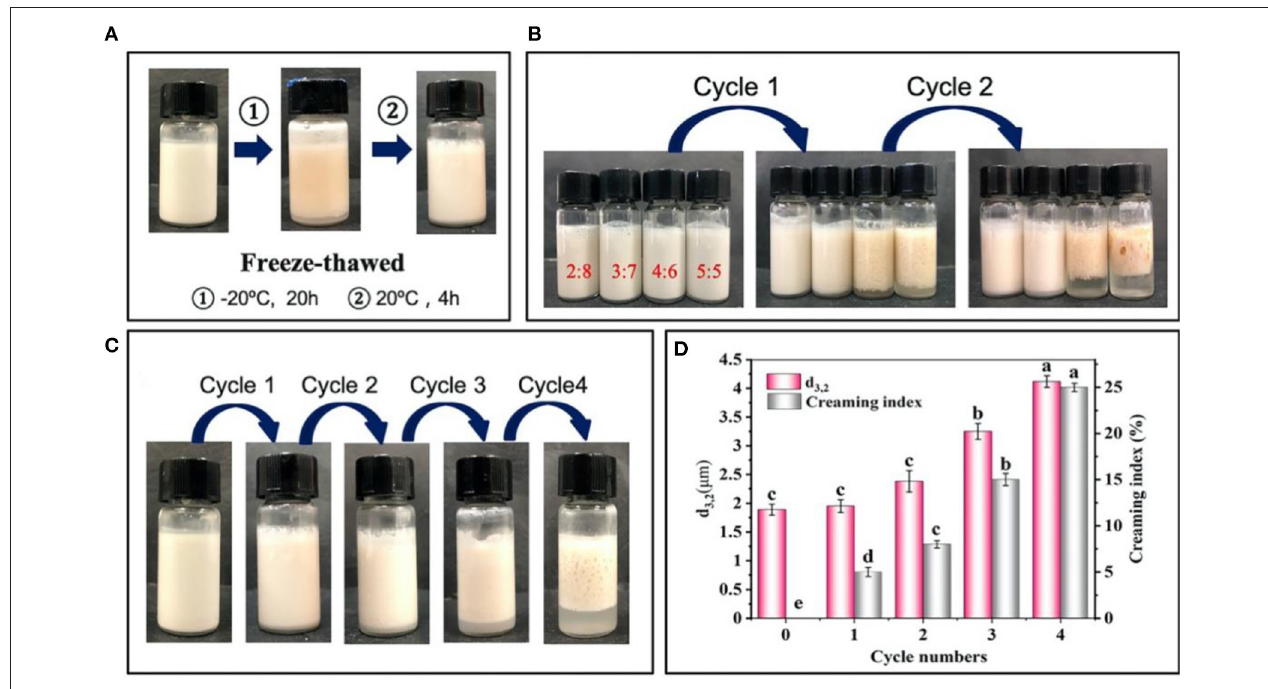
FIGURE 5 | Changes in visual appearance (A,B) of emulsions prepared by 2% proteins and 3:7 oil/water ratios (C) before and after freeze-thaw treatment. (D) Average diameter (d 3,2 ) and creaming index of emulsions prepared by 2% proteins and 3:7 oil/water ratio after freeze-thaw treatment. Mean values followed by different letters are significantly different ( P <